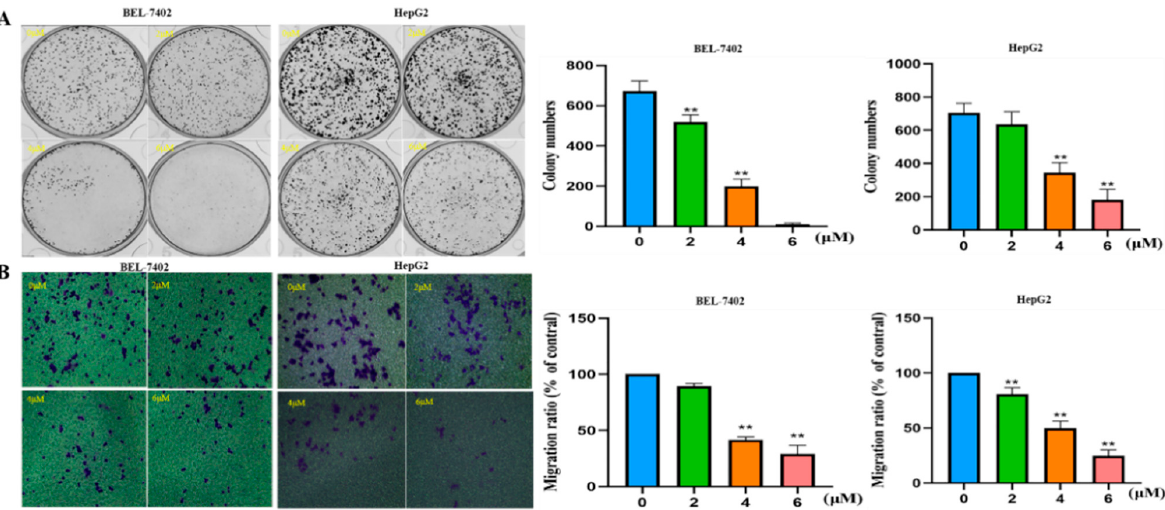
Figure 3. Suppression of cell lines grown in vitro. ( A ) Number of cell clones after treatment with ZS17